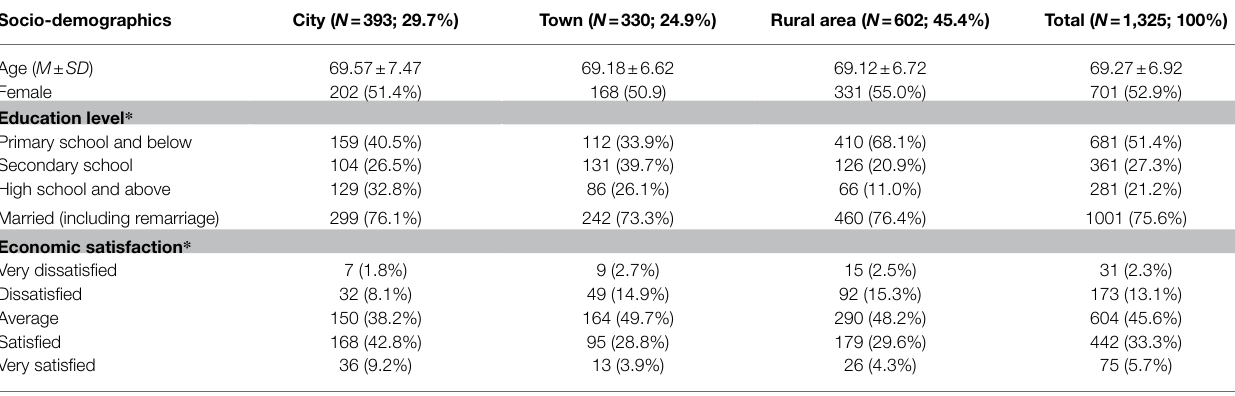
TABLE 1 | Demographic characteristics of older adults in cities, towns, and rural areas. Socio-demographics